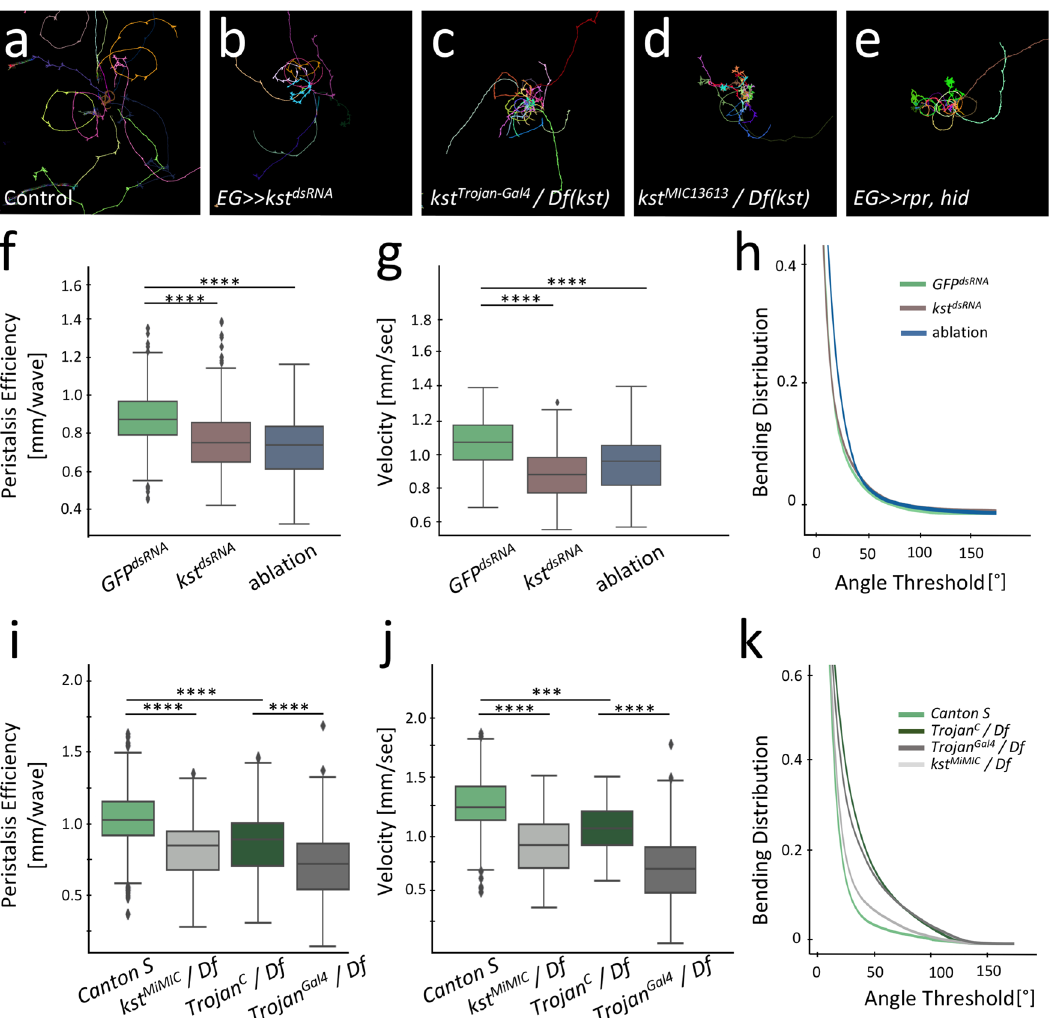
the genotype [ 83E12-Gal4 AD , repo-Gal4 DBD , UAS-GFP dsRNA ]. Larvae move in long run phases. b Upon kst knockdown in ensheathing glia (EG) only [ 83E12- Gal4 AD , repo-Gal4 DBD , UAS-kst dsRNA ], larvae do not explore the tracking arena. c The insertion of a Trojan Gal4 element into the fi rst coding exon of kst- RE(RG) generates an PE and PG isoform speci fi c mutant (see Fig. 8). Larvae with the genotype [ kst TrojanGal4 / Df(3 L)ED208 ] show a comparable